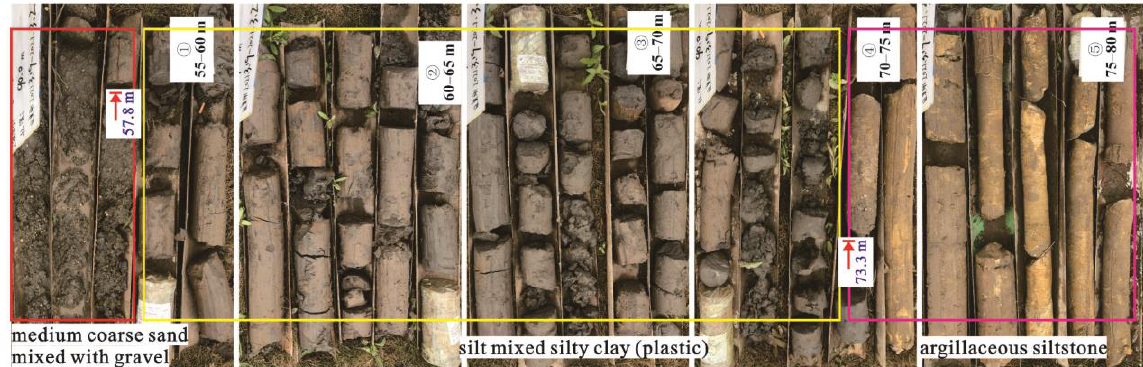
Figure 7. Partial core sample photos of borehole zk10.